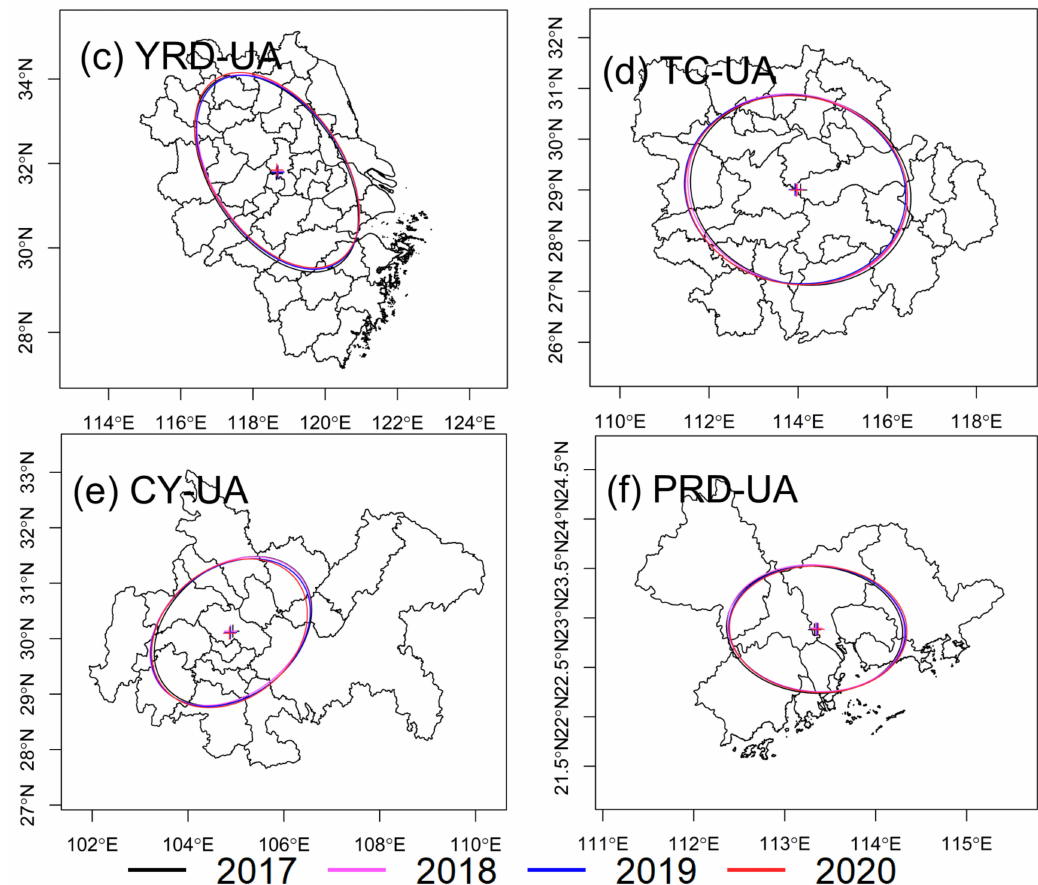
Figure 5. Spatial changes in the mean center and standard deviation ellipse (directional distributions) of PM 2.5 concentrations in six urban agglomerations of China, from 2017 to 2020. ( a ) BTH-UA, ( b ) CP-UA, ( c ) YRD-UA, ( d ) TC-UA, ( e ) CY-UA and ( f )